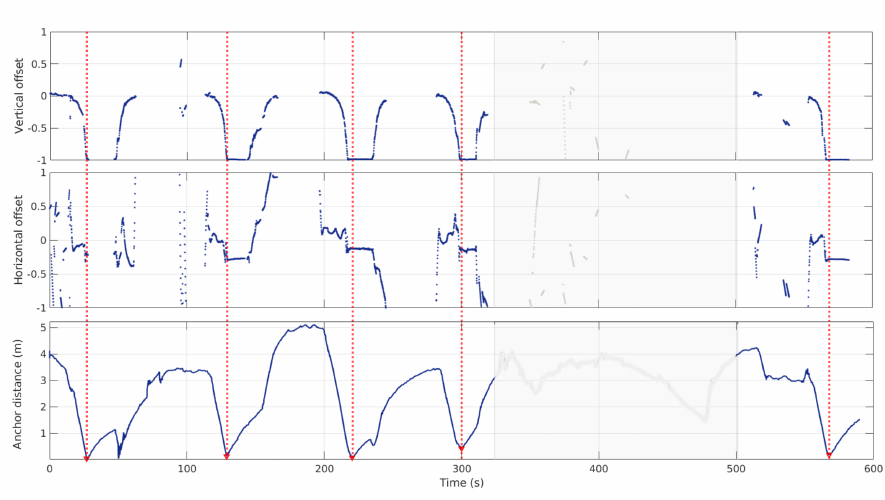
Figure 20. Offsets during the docking experiment. Five separate successful docking attempt completions marked in red.